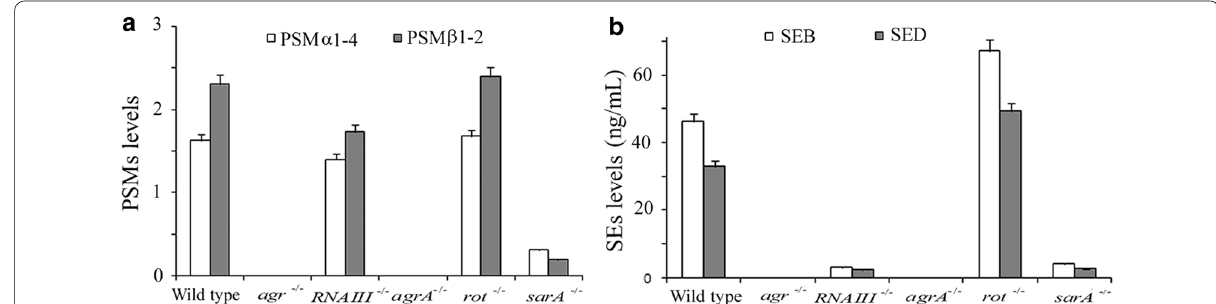
Fig. 4 PSMs and SEs expression in representative foodborne S. aureus and its variants. Results were Mean PSMs expression, expressed as the ratio of PSMs in tested strains to those in USA300. b SEs